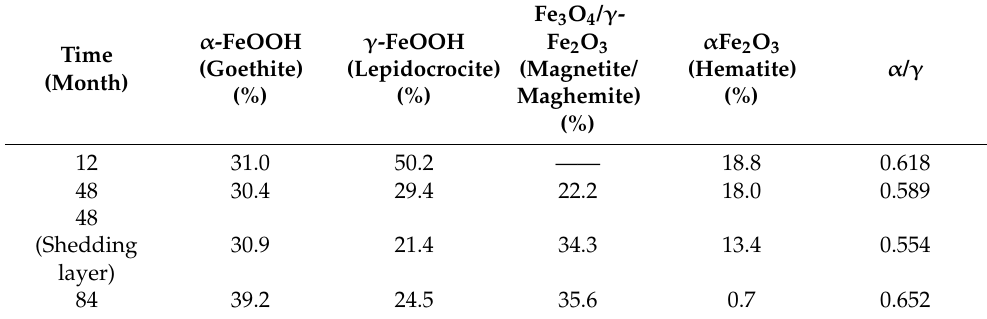
Figure 11. Full spectrum fitting analysis.